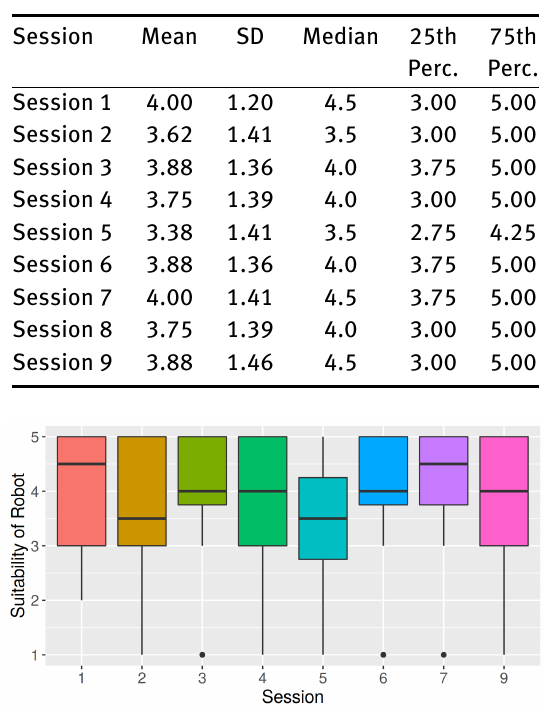
Figure 7: Responses to Global Evaluation measures across sessions for Robot for